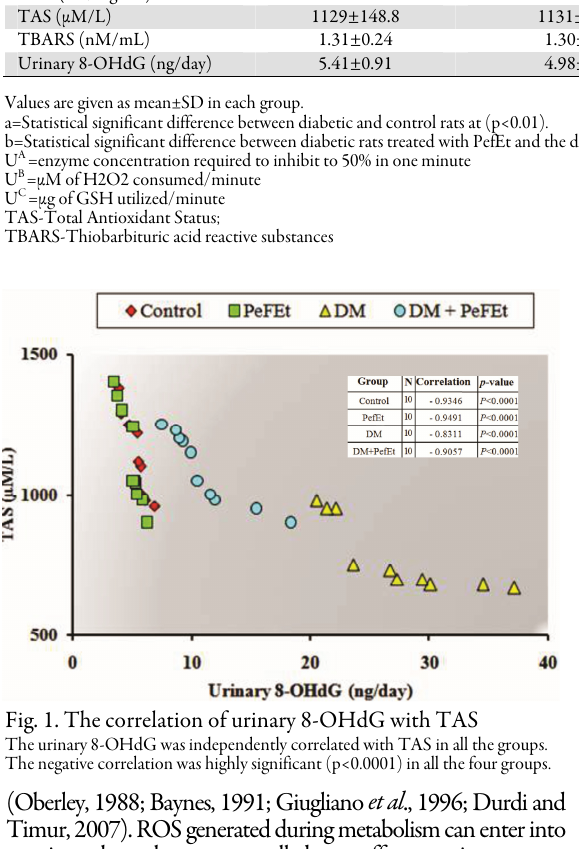
Table 2. Antioxidants, MDA and urinary 8-OHdG in the different studied groups Groups Control PefEt Diabetic